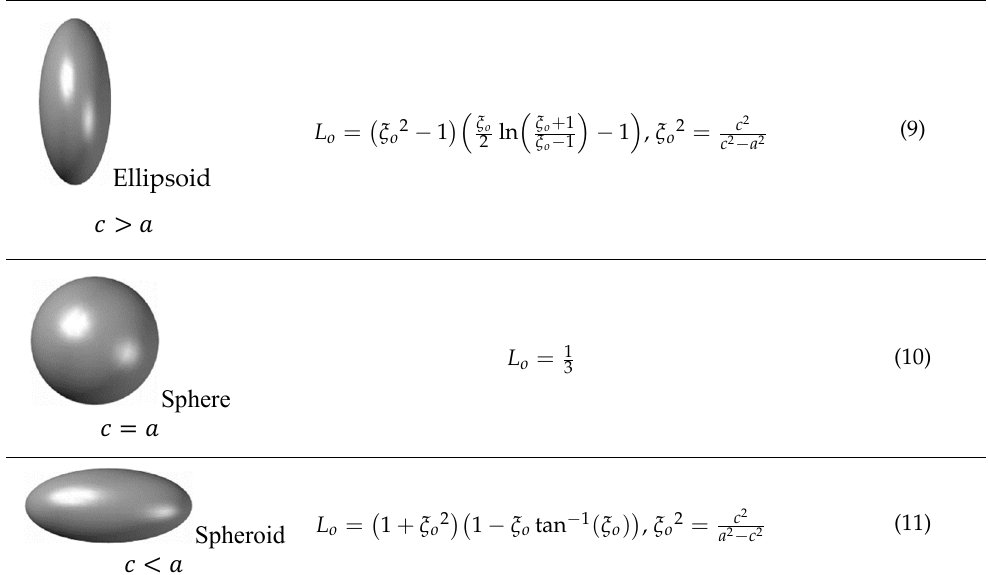
Table 1. Depolarization factor at different geometry conditions.